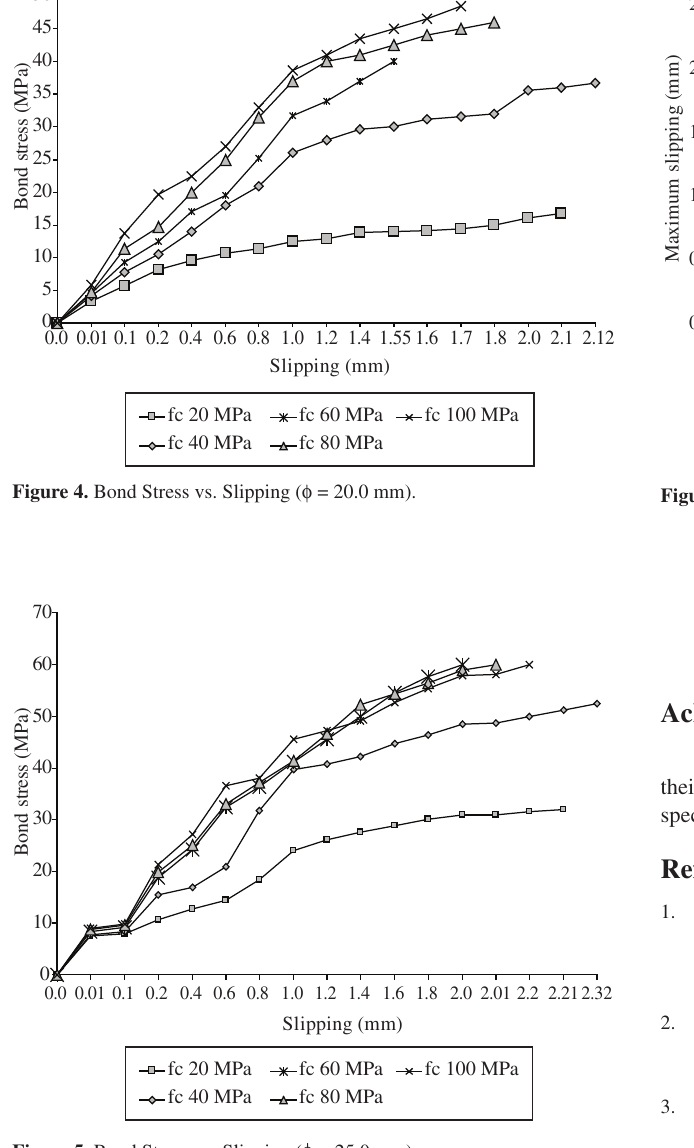
Figure 5. Bond Stress vs. Slipping ( f = 25.0